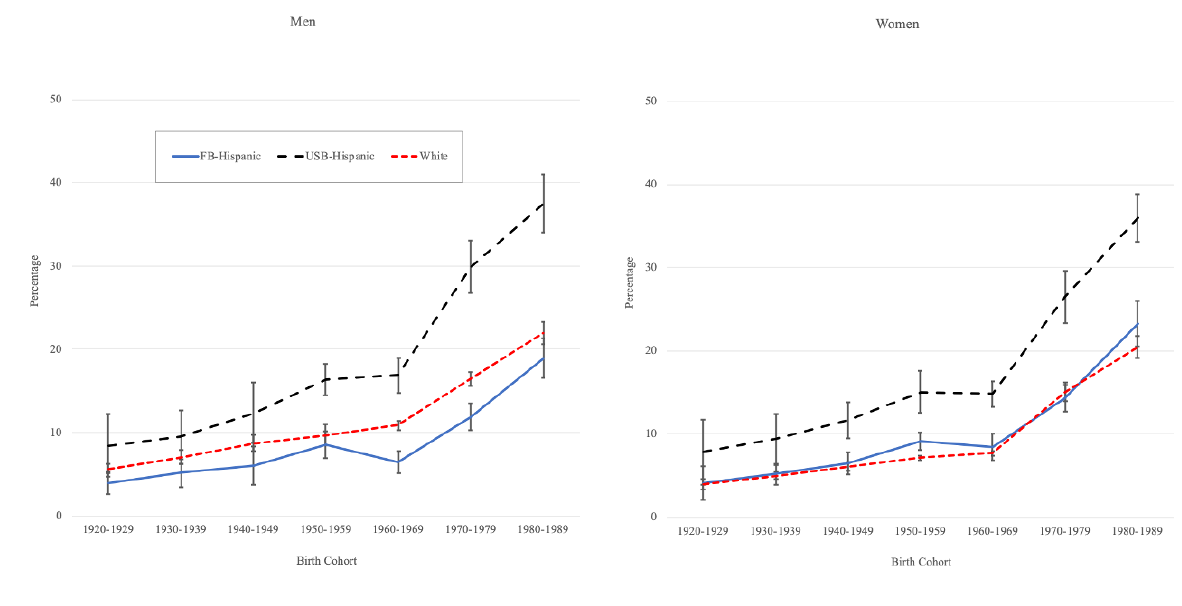
Figure 2: Percentage obese (BMI ≥ 30) at age 25 by birth cohort, ethnicity/nativity, and gender. Source: 1989 to 2014 National Health Interview Survey and 1999 to 2014 National Health and Nutrition Examination Survey. FB, foreign-born; USB,